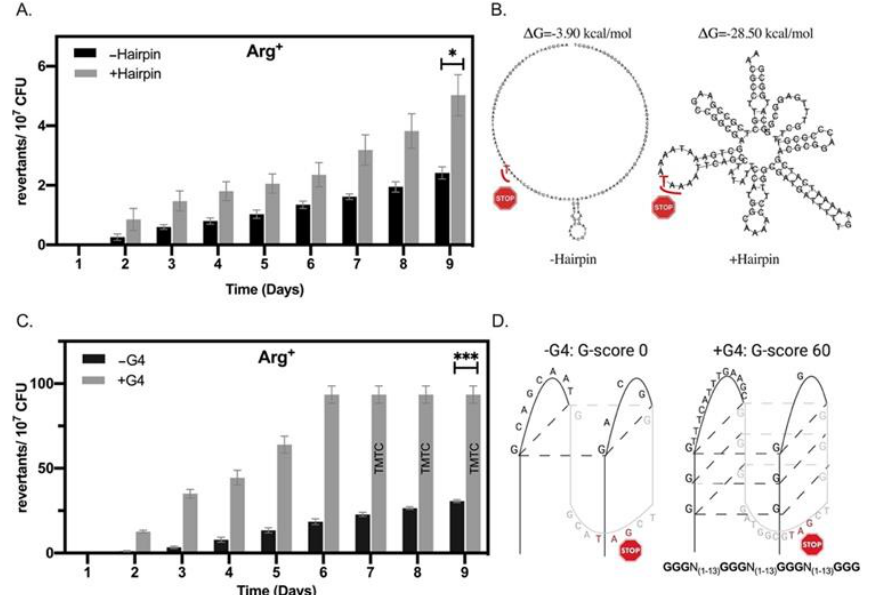
Figure 2. Hairpins and G4 DNA-forming motifs promote mutations in stationary phase B. subtilis cells. ( A ) Stationary-phase mutagenesis assay results for +/ − hairpin strains. ( B ) Mfold predicted hairpin structures for 120 bp region in argF (positions 82–202). ( C ) Stationary-phase mutagenesis assay results for +/ − G4 strains. ( D ) Schematic of predicted G4 DNA structures and G-score in argF (position 182–219). Please note the differences in scale between the two graphs. Bars represent the mean, and error bars are SEM ( n = 3). Statistical significance was determined using a Student’s t -test * p < 0.05, *** p < 0.001.